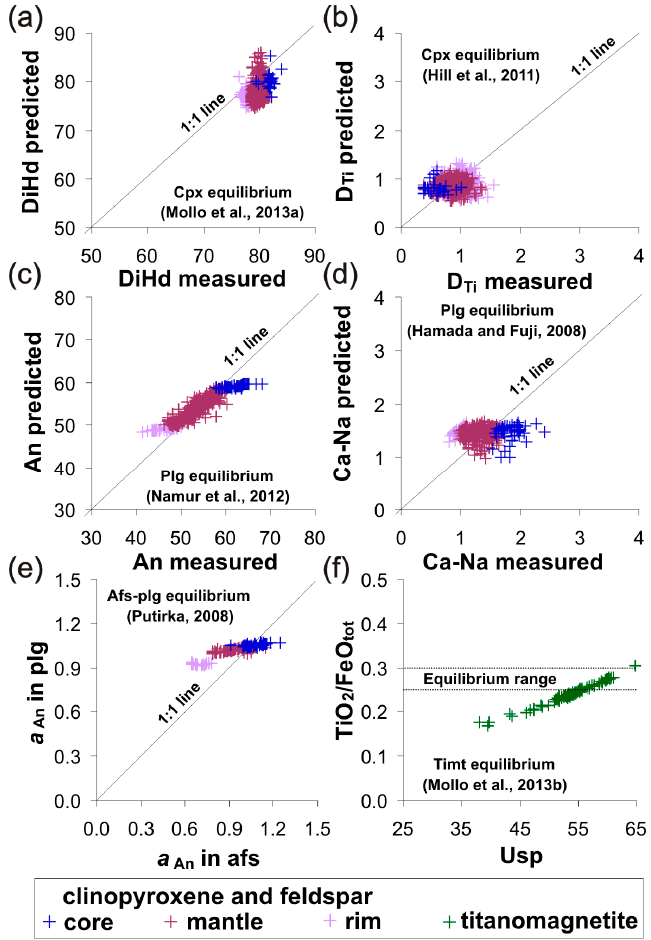
Figure 6. Test for equilibrium between the bulk rock analysis (i.e., the original magma composition) and clinopyroxene ( a and b ), feldspar ( c – e ) and titanomagnetite ( f ). The DiHd (diopside + hedenbergite) model comes from Reference [35] with an equilibrium range 0–0.1. The partitioning of Ti (D Ti ) between clinopyroxene and melt is predicted by the lattice strain equation of Reference [65]. An (anorthite) in plagioclase is predicted by the thermodynamically-derived expression of Reference [70]. The Ca–Na exchange model comes from Reference [71]. The feldspar activity model (i.e., the activity of anorthite in plagioclase and alkali feldspar) has been derived by Reference [59]. The TiO 2 /FeO tot equilibrium range between 0.25 and 0.30 has been experimentally-measured by Reference [37].